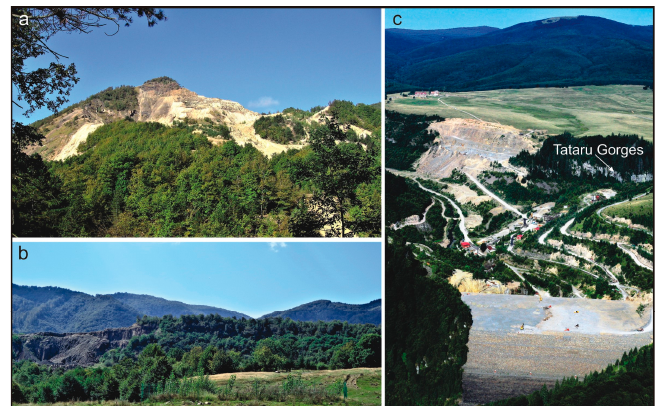
Figure 19. Anthropic landforms/landscapes in the Gutâi Mountains: Mine Hill (Mons Medius) abandoned mining open-pit ( a ). (Photo credit: Carol Kacso). Cherec andesitic sill partially destroyed by a building rock materials active quarry ( b ). (Photo: Marinel Kovacs). The present-day construction of the huge Runcu dam near the T ă taru Gorges, a fourth IUCN category protected area ( c ) (Photo credit: Péter Lengyel).